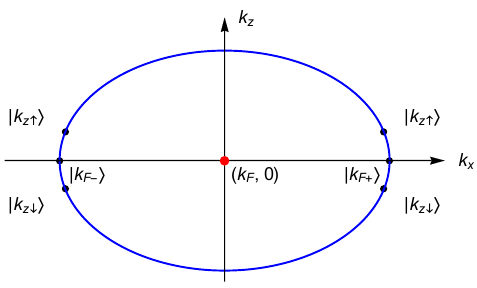
Figure 9 . The diagram to illustrate the label of states which contributes nontrivially to the discrete Berry phase. The normalized inner product given by the adjacent points in the same upper or lower plane is one and gives a vanishing contribution to Berry phase. The net contribution of nontrivial discrete Berry phase is from the combination of h k which can give a minus sign.